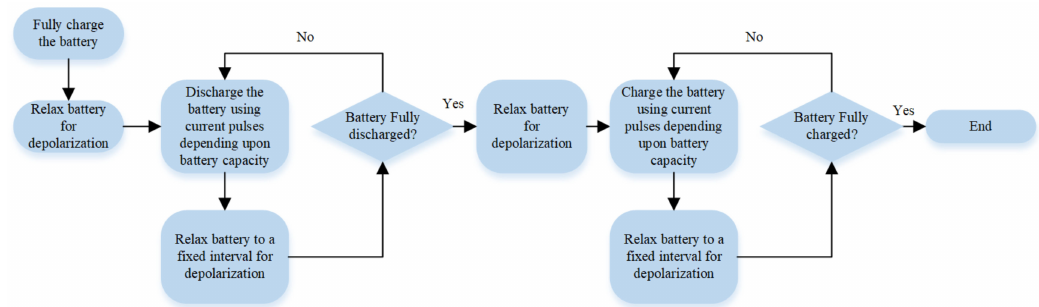
Figure 6. Working cycle of OCV-SOC estimation